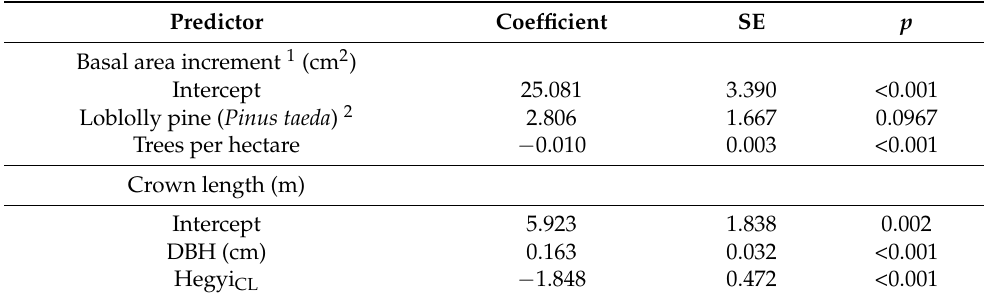
Table 4. Linear mixed-effects model parameter coefficients, standard error (SE), and p -values by response